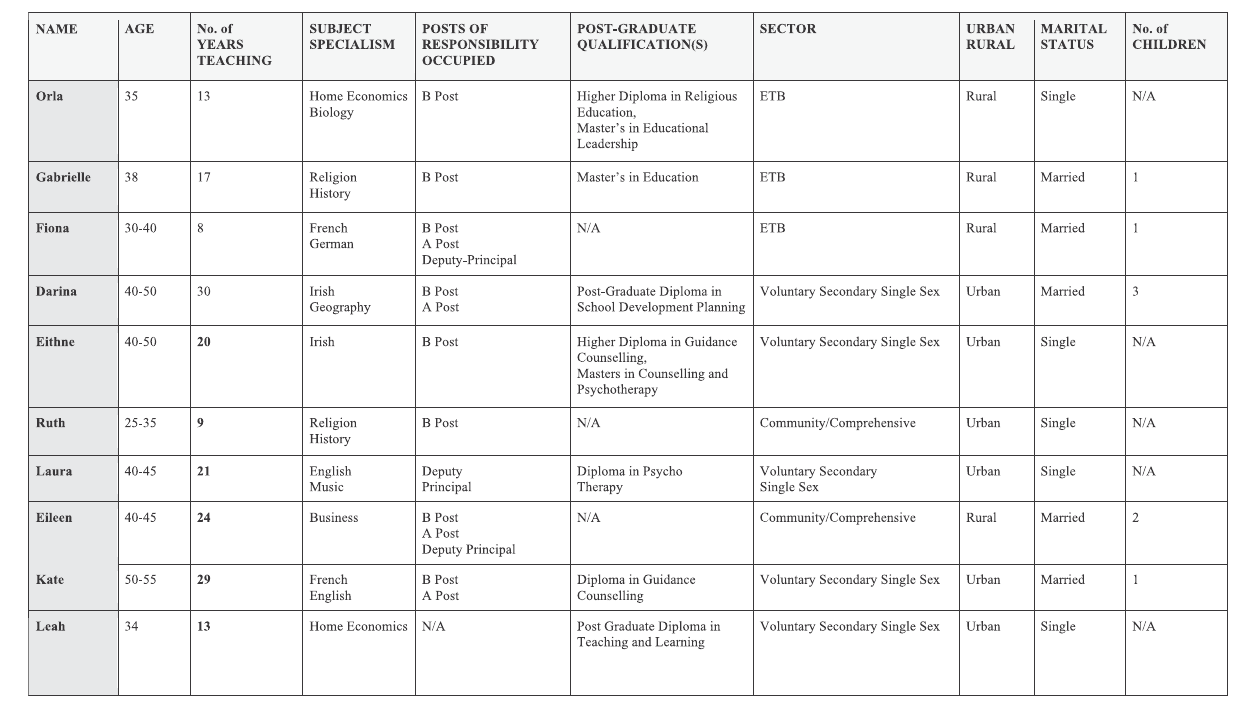
Frontiers in Education |